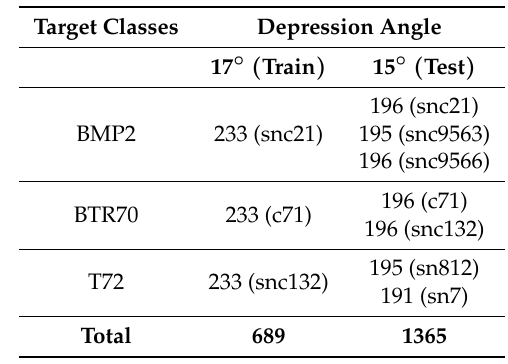
Table 4. Number of SAR images in MSTAR database under configuration variation: EOC-1. The content in brackets represents the serial number of configuration.